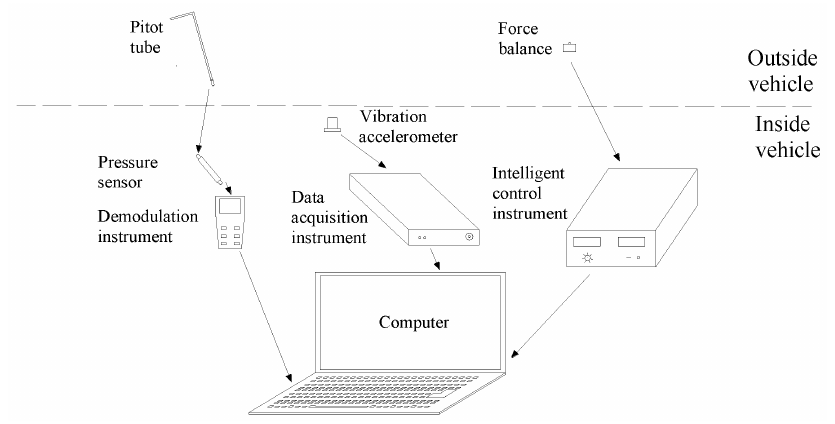
Figure 4. Data acquisition systems of the transiting tests.